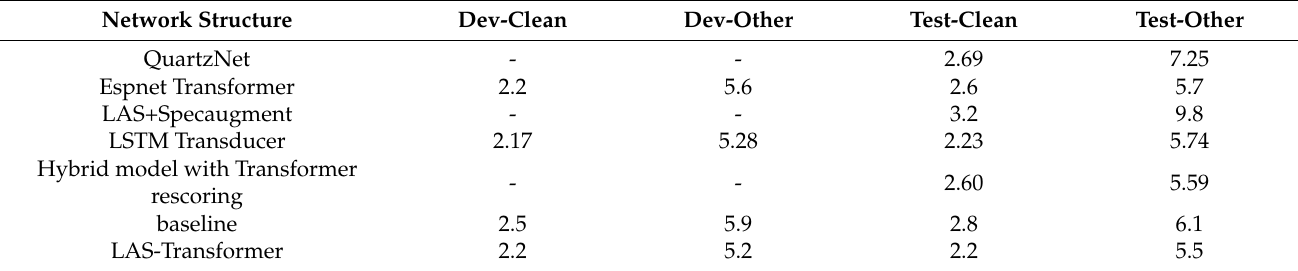
Table 1. Comparison of WER of each model on LibriSpeech